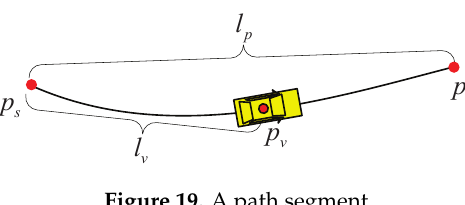
Figure 19. A path segment.